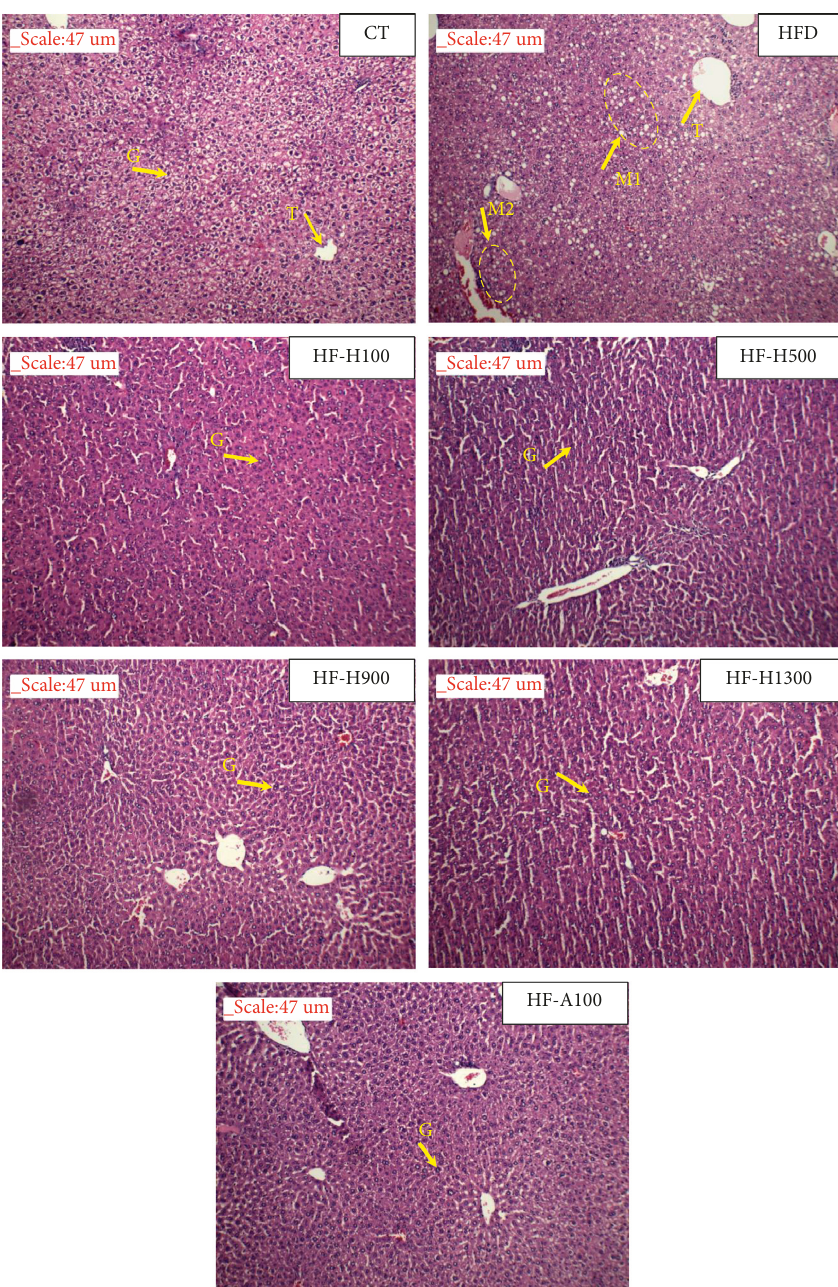
Figure 6: Photomicrographs of liver tissues (T: central vein; G: hepatocytes; M1: macrosteatosis; and M2: